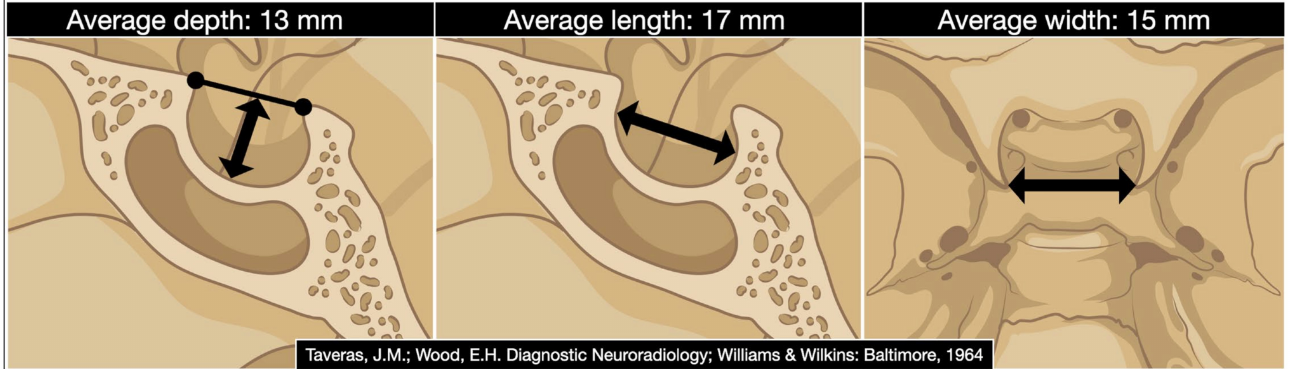
Figure 1. The digital drawing shows the sellar region’s average depth, length, and width. (Date derived from Taveras JM, Wood EH. Diagnostic Neuroradiology. Baltimore: Williams and Wilkins; 1964